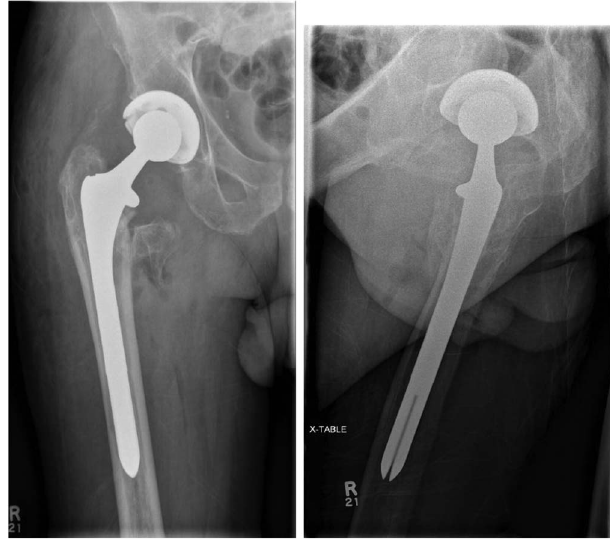
Figure 2. A and B: Complex primary THA.